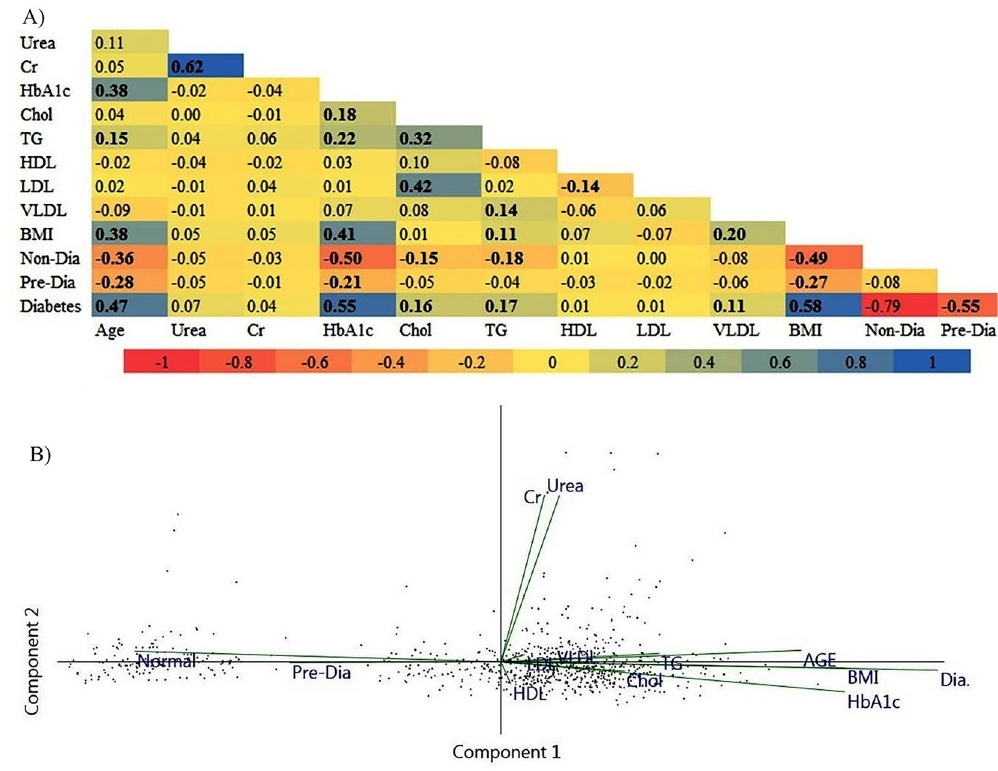
Figure 2. ( A ) Pairwise-Pearson correlation between blood biochemical markers, BMI, age and diabetes incidence. The color intensity is proportional to the correlation coefficients. The scale bar is the color range for different R values. Correlations that are significant at P < 0.05 are shown in the bold profiles. ( B ) Biplot of PCA derived from the blood biochemical markers, age, BMI, and diabetes incidence. Vectors with close angles (< 45°) indicate a strong correlation, vectors that are perpendicular indicate no correlation, and vectors in opposite directions (approaching 180°) indicate a negative correlation. Dia diabetes, Pre-Dia pre-diabetes, Normal non- diabetes, Cr creatinine, Chol cholesterol, TG triglyceride, BMI body mass